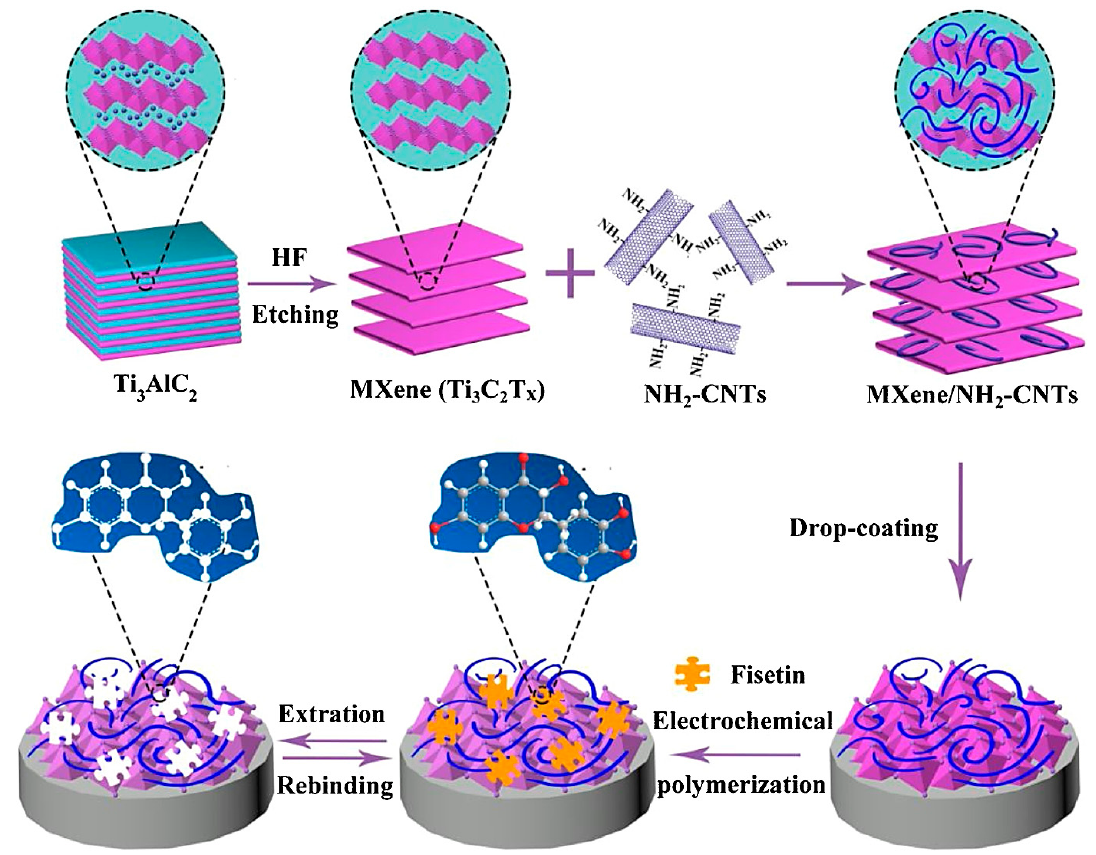
Figure 2. The preparative process of molecularly imprinted polymer (MIP)/MXene/amino (NH 2 )-CNTs/glass carbon electrode (GCE) for specific sensing of fisetin, along with the related adsorption mechanisms. Adapted from Ref [81] with permission. Copyright 2020 Elsevier.